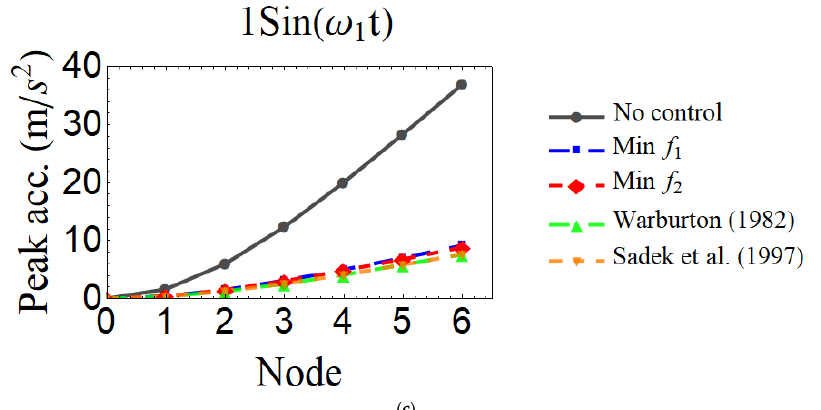
Figure 11. The peak node responses of the cantilever beam in comparison with [29], [30] for the first mode control considering ( a ) peak displacements, ( b ) peak rotations, and ( c ) peak accelerations.